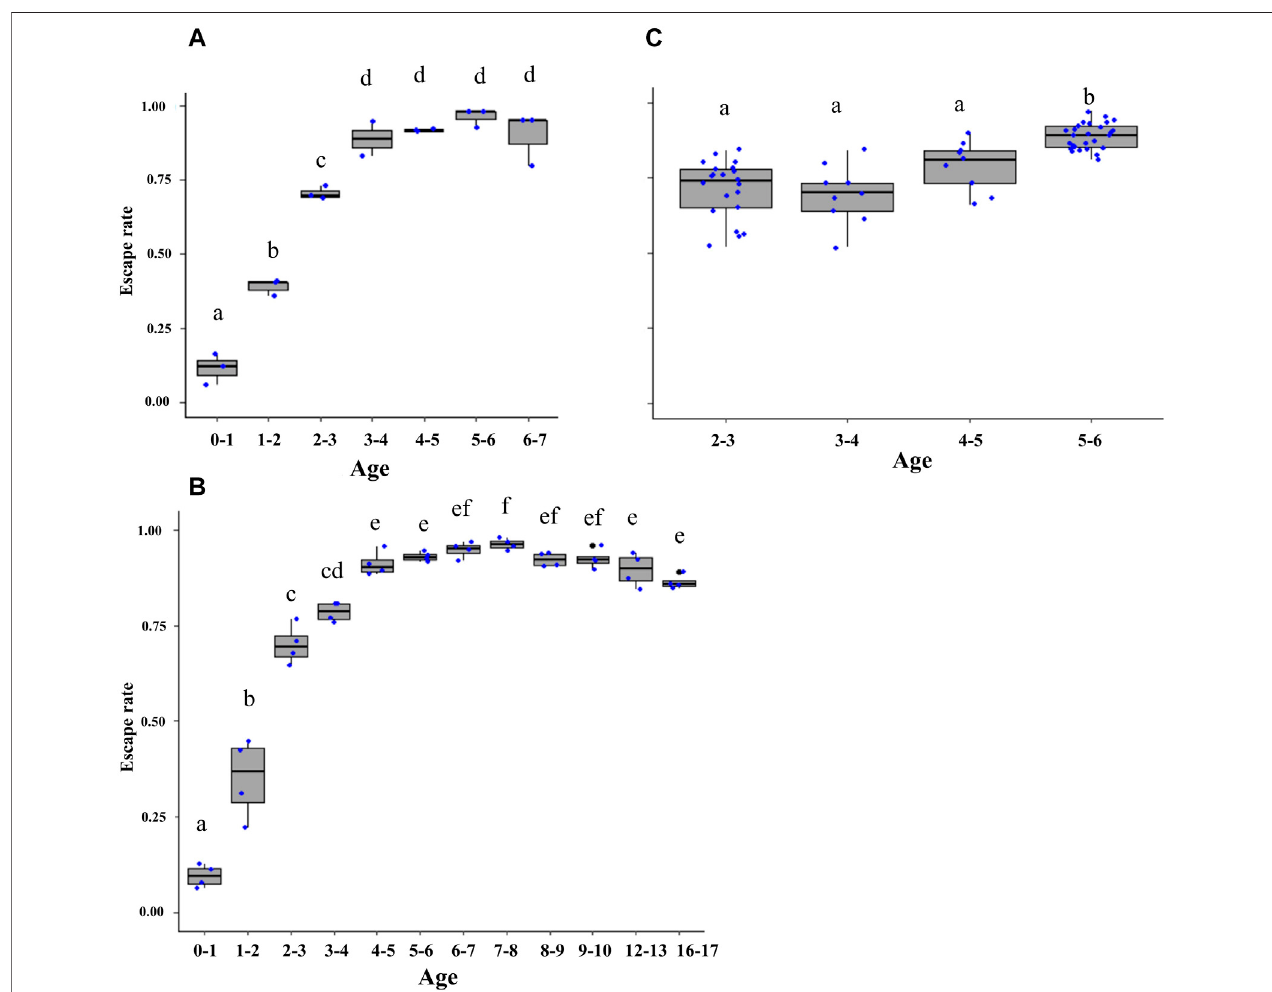
FIGURE6| Escaperatesacrossadultmale Aedesaegypti (Brazilian strain) (A) , Aedesaegypti (Singaporeanstrain) (B) ,and Aedesalbopictus (C) agegroups. Age ranged from below one to eight days old (A) ; from below 1 day to 17 days (B) ; from two-to-six – day-old mosquitoes (C) . Black bars indicate the median; the upper and lower limits of each box indicate the interquartile range. Each dot represents a value of the observed escape rate per replicate. Different letters denote signi fi cant differences between age groups.